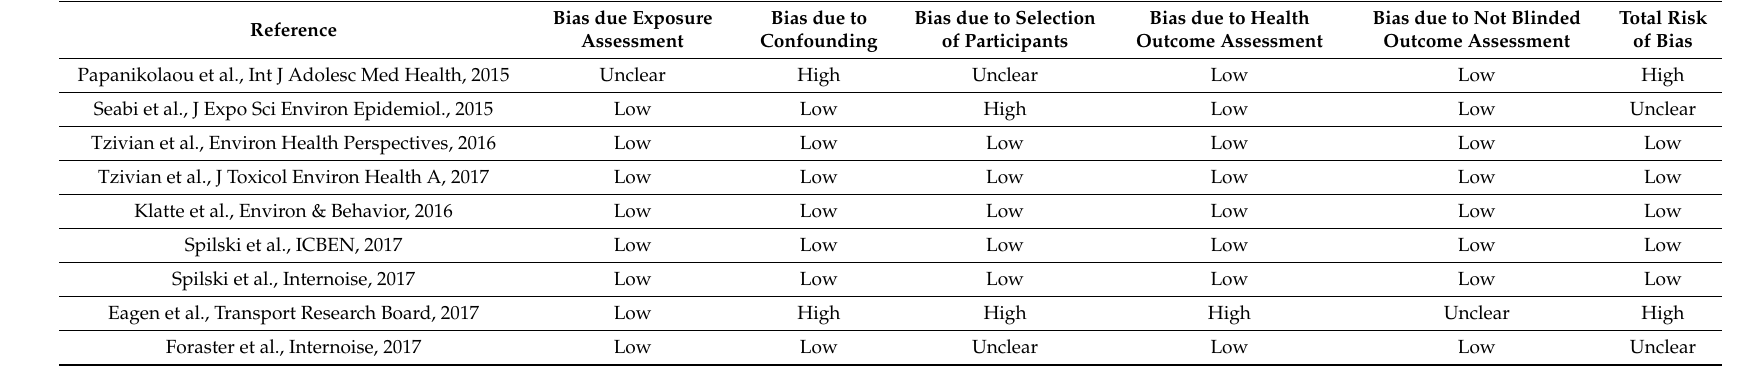
Table 6. Cognition: risk of